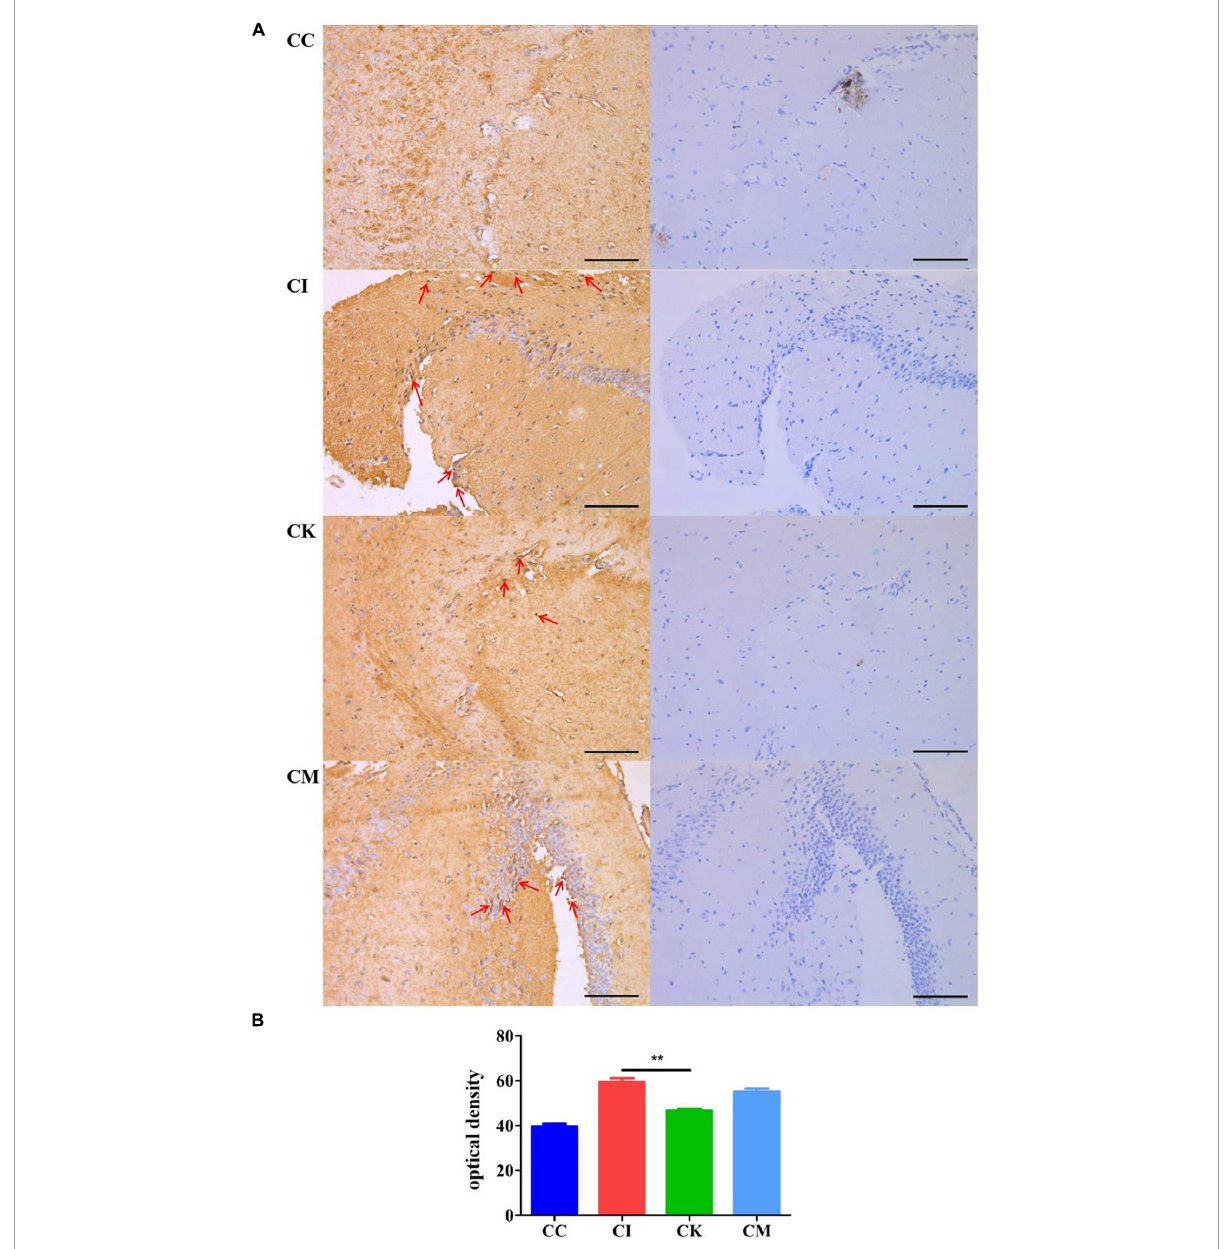
FIGURE7 β -amyloid deposition in mice with chronic T. gondii infection at 42 dpi. CC: no T. gondii + PBS; CI: 3 T. gondii cysts + PBS; CK: 3 T. gondii cysts + koumiss; CM: 3 T. gondii cysts + mare’s milk; (A) The immunohistochemical staining results of the CC, CI, CK and CM groups. Red arrows represent brownish yellow particles caused by amyloid deposition. (B) The optical density value of different treatment groups. ** P < 0.01. All data are expressed as mean ± SD. Scale bars: 100 µ m.